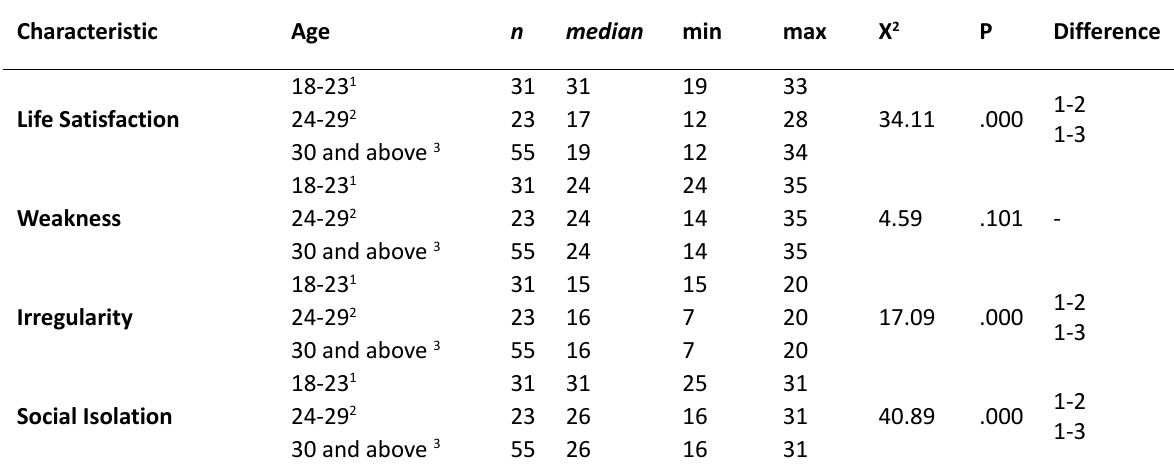
Table 4. Assessment of Participants’ Life Satisfaction and Alienation Level and Perceptions According to Their Marital Status Characteristic Life Satisfaction Weakness